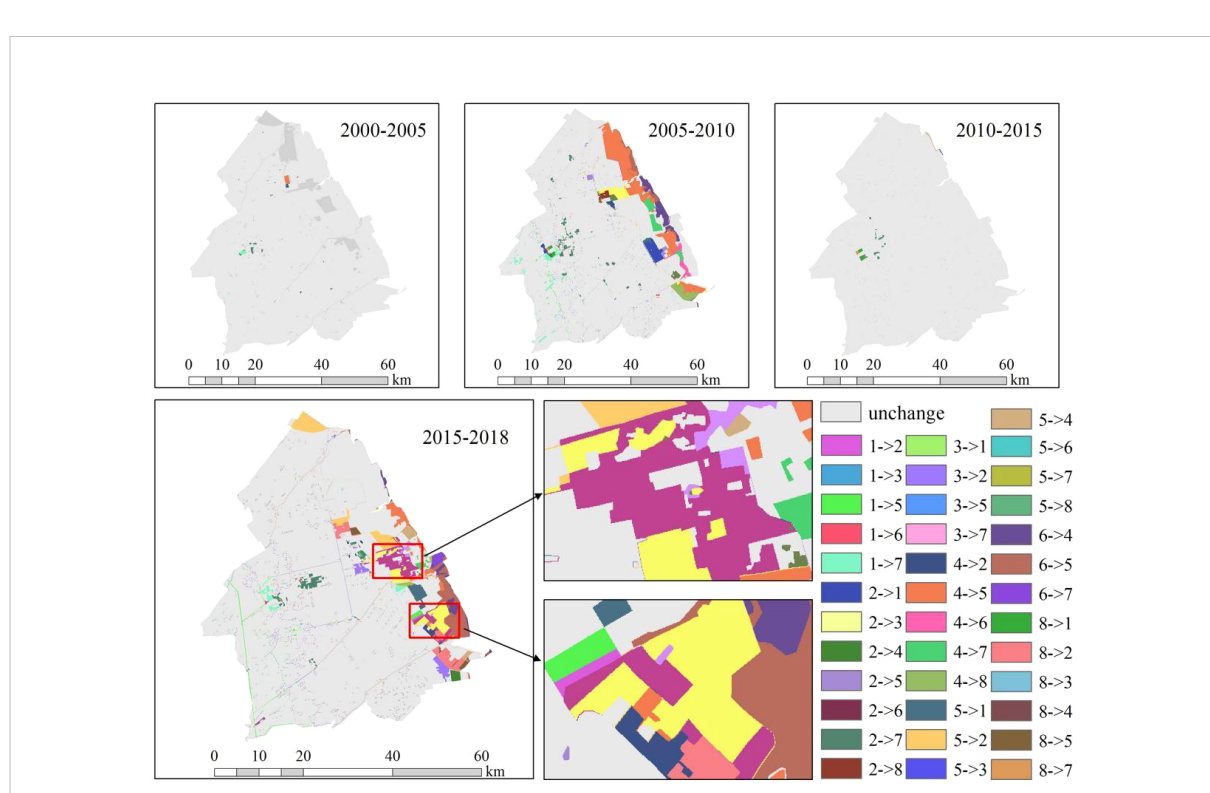
FIGURE 5 Land use types transfer from 2000 to 2018, Sankey